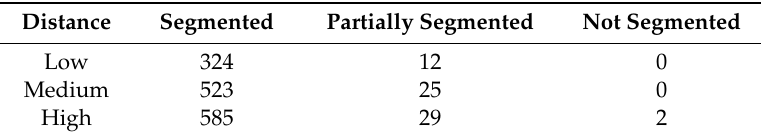
Table 3. Results of land segmentation.